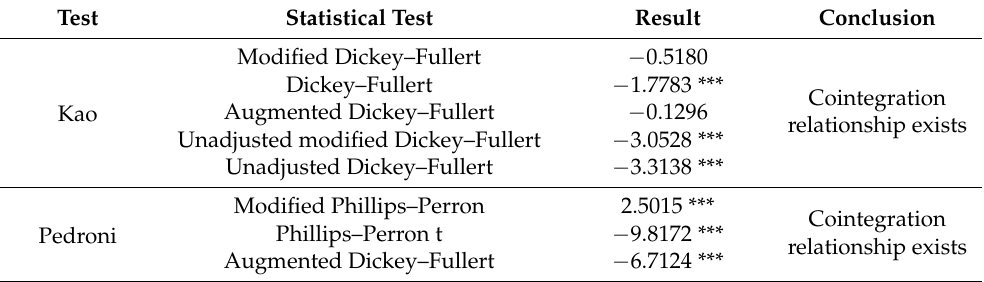
Table 5. Results of Cointegration Test.